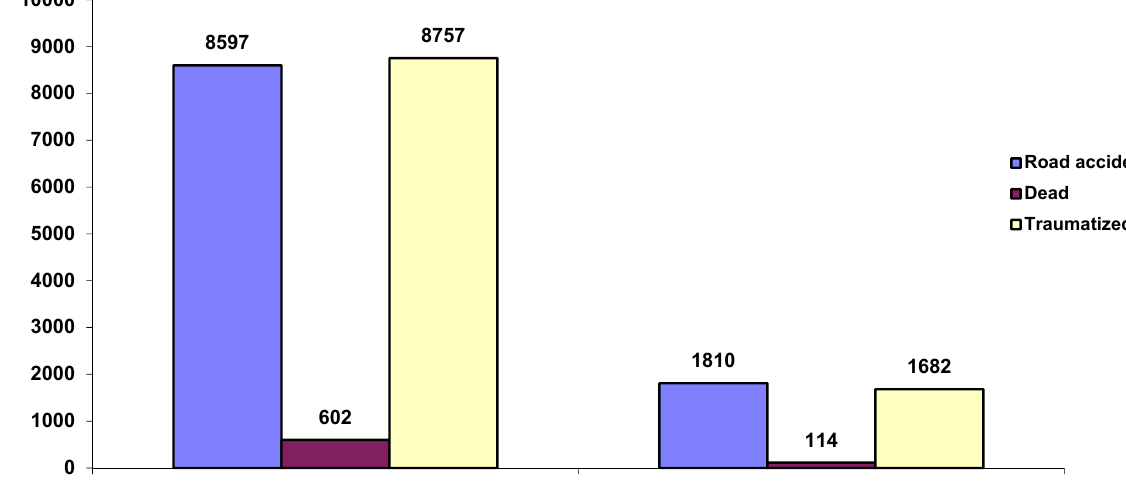
Figure 1. Children who have suffered road accidents (years 2000 –